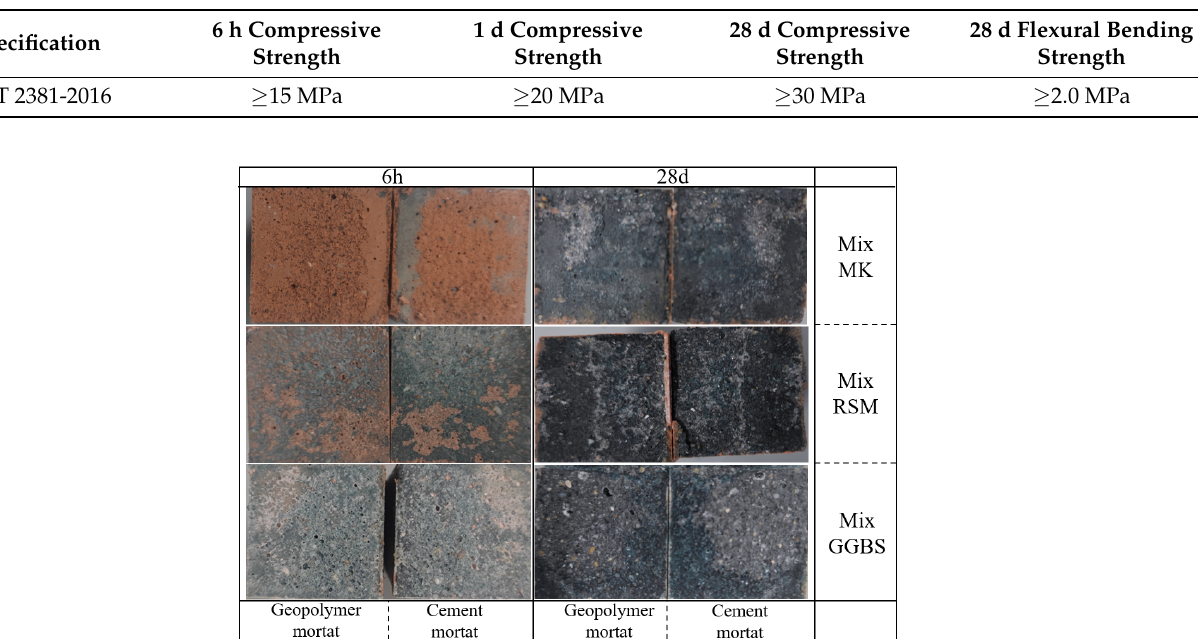
Figure 18. Mechanical properties test results: ( a ) compressive strength; ( b ) bond strength. Table 8. Mechanical strength as specified in the standard.